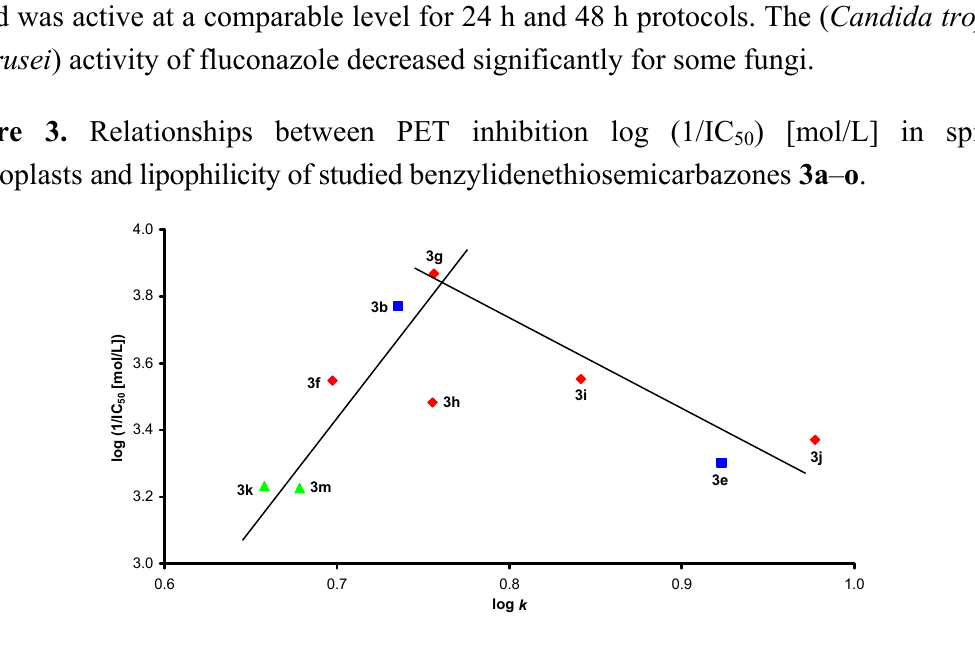
) [mol/L] in spinach 50